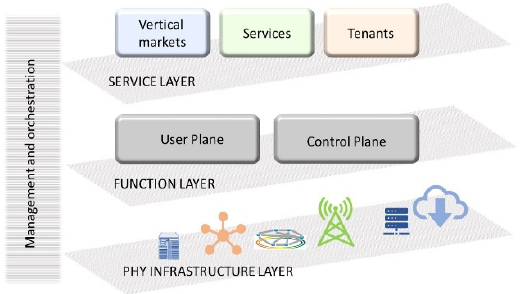
Figure 2. Network slicing conceptual architecture.